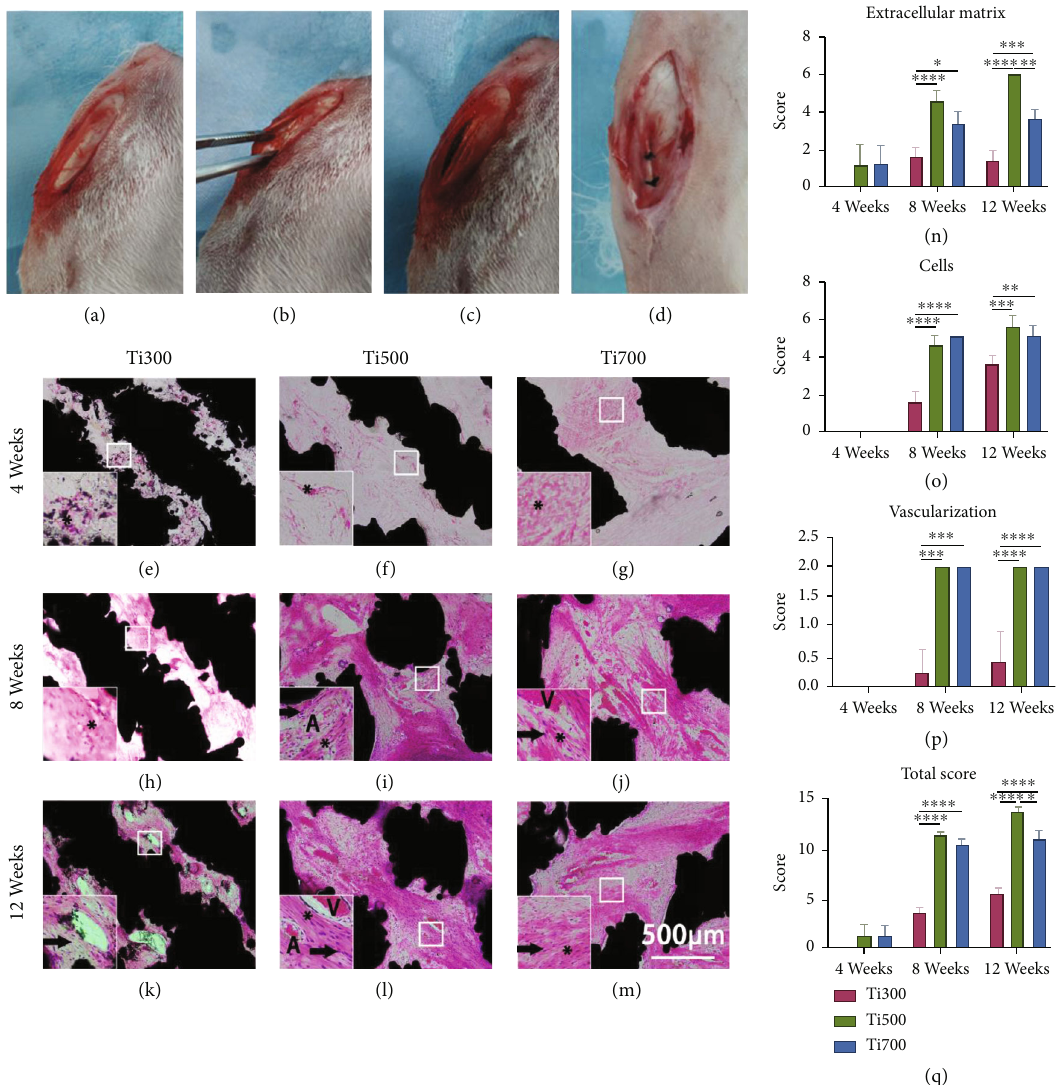
Figure 2: Improvement of histological performance: (a) exposed patellar tendon through paramedian incision, (b) slit in the coronal plane of the patellar tendon, (c) implantation of the titanium material, and (d) suture of the patellar tendon slit. (e) – (m) Representative HE- stained sections of each sample group. (n) – (q) Statistical analysis of histological scores from each group at di ff erent time points ( n = 5 ; A: artery; V: vein; ∗ : fi ber; arrow: